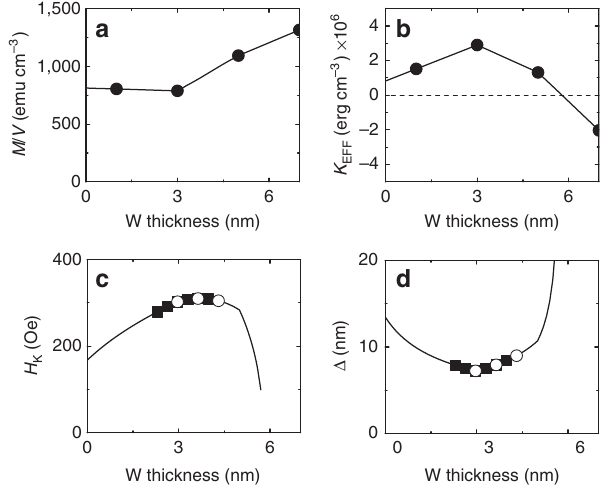
Figure 3 | Magnetic properties of the films. ( a , b ) W thickness dependence of the volume averaged saturation magnetization M/V ( a ) and the magnetic anisotropy energy K EFF ( b ). The solid line shows linear interpolation of the data. ( c , d ) DW anisotropy field H K ( c ) and the wall width parameter D ( d ) calculated from the interpolated data shown in a and b . The symbols represent values of H K and D that are used in the calculations presented in Fig. 4 for 5 m m wide wires (open circles) and for 50 m m wide wires (solid square). All results are from film set